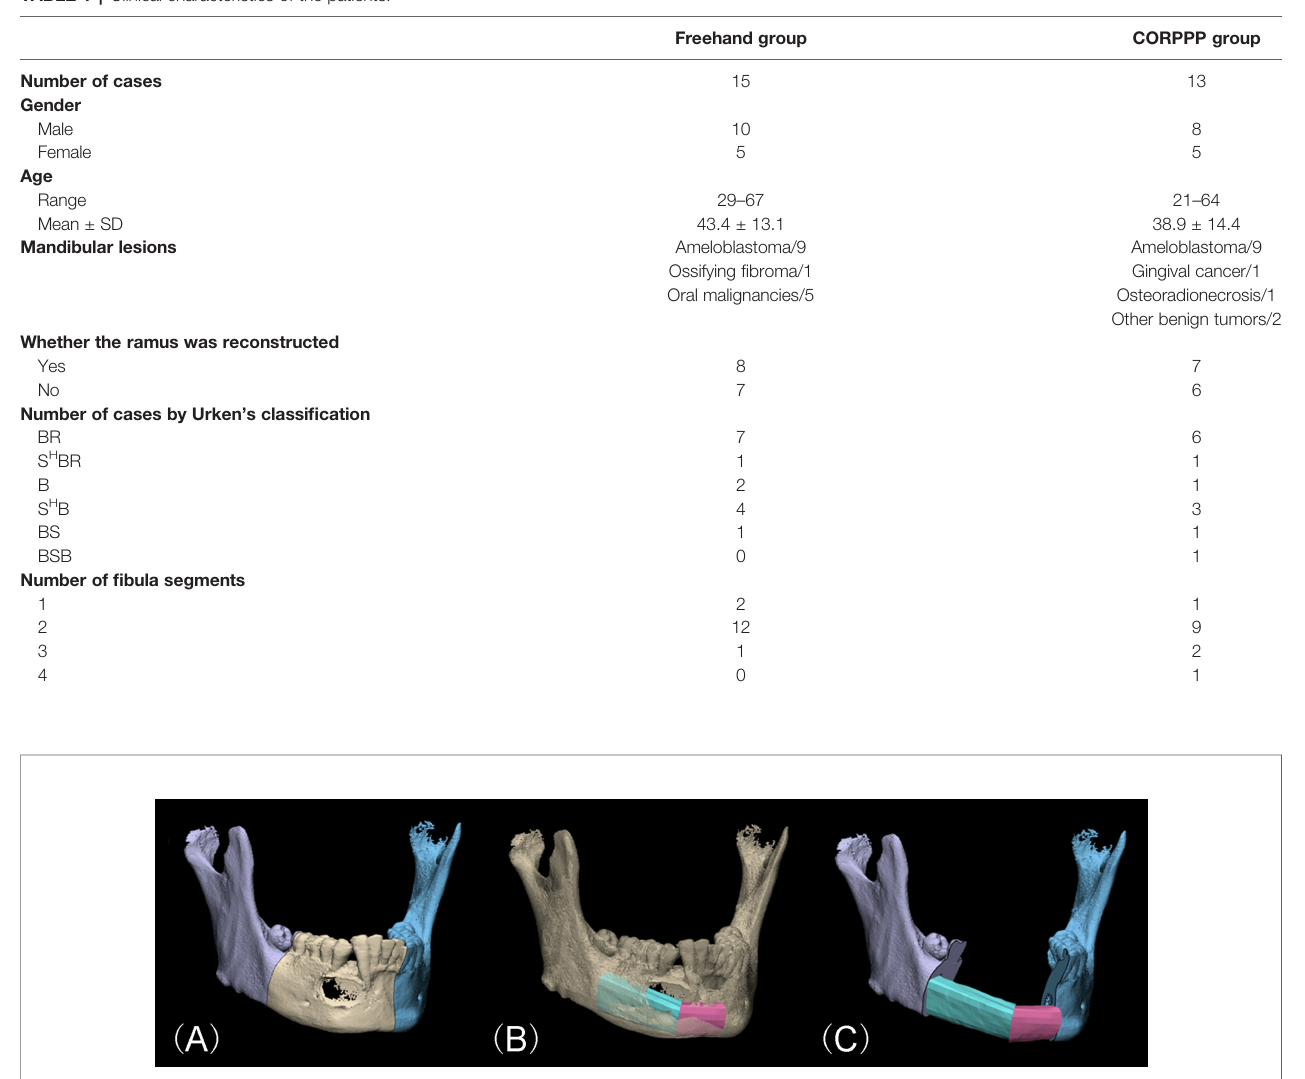
FIGURE 1 | Virtual surgery simulation of mandibular lesion resection and fi bular reconstruction. (A) Determination of the range of the mandibulectomy. (B) Arrangement of the fi bula segments into the defect region according to the contour of the original mandible. (C) Expected virtual mandibular model after fi bular reconstruction.